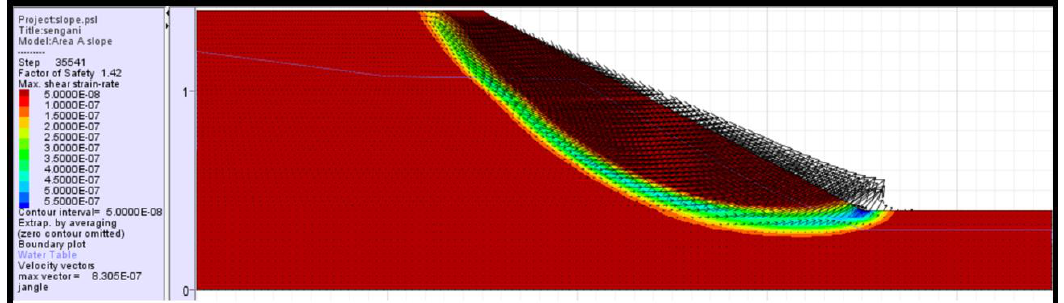
Figure 15. Simulated FoS of the clay soil slope using FLACSlope in sunny conditions with a water table with 1000 m 3 of water. Note that maximum shear strain simulated ranges between 5.0 × 10 − 8 to 8.30 × 10 − 7 .